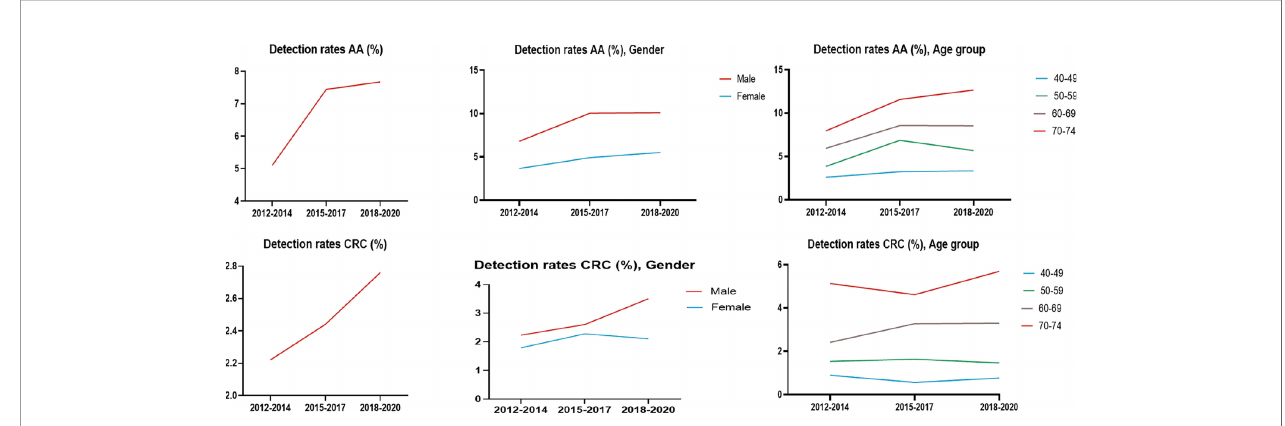
FIGURE 9 | Analysis of CRC/AA detection rate in 3 cycles of